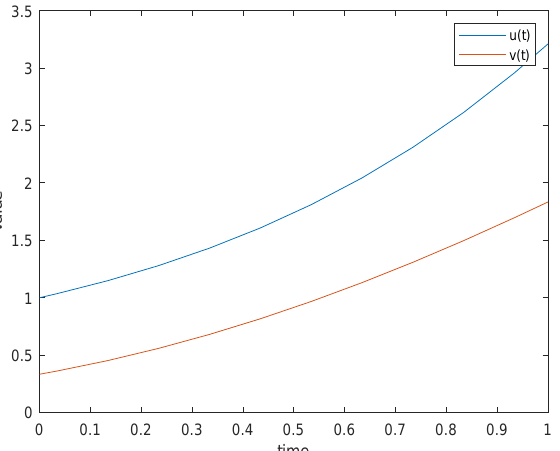
Figure 2. Numerical simulation of the integer-order equation solutions corresponding to Example 1.